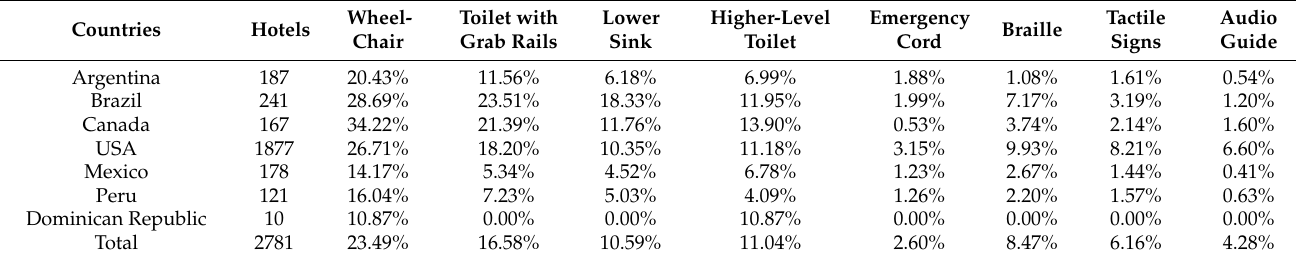
Table 4. Distribution of the accessible installations for the countries in